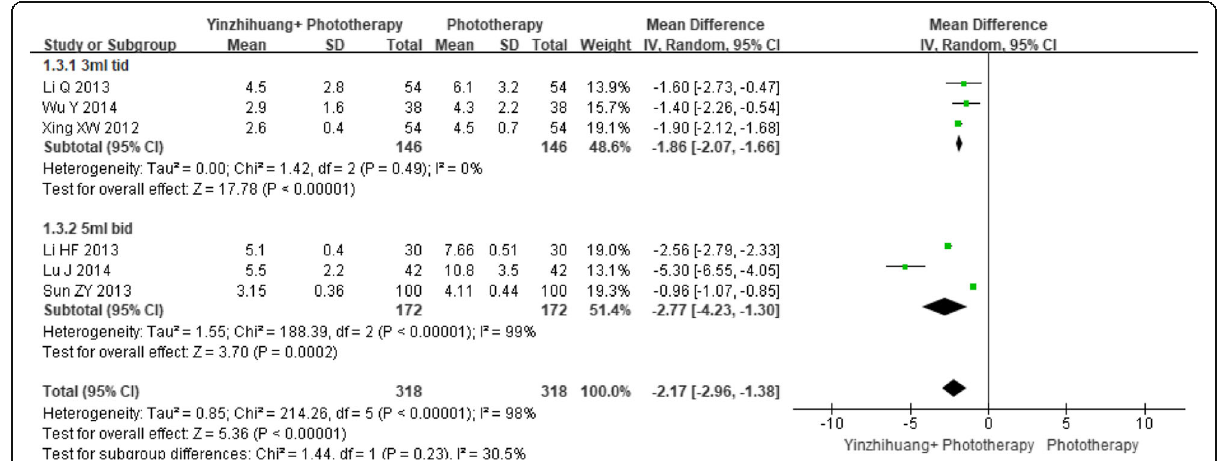
Fig. 7 Forest plot of time to jaundice resolution and subgroup analysis based on dosage of Yinzhihuang oral liquid